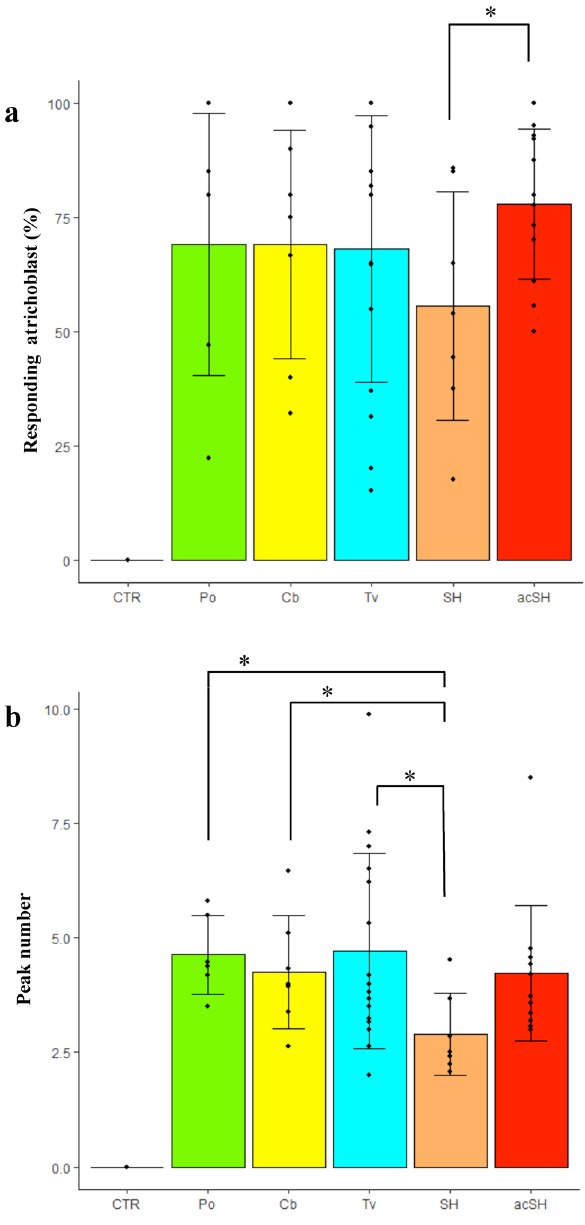
Figure 3. Calcium spiking response to 1 mg/L CO treatment in M. truncatula atrichoblasts. All CO solutions activated nuclear calcium spiking, in a comparable number of cells (expressed as percentage in a ). Nevertheless, the average number of peaks recorded over 30 min ( b ) indicated a significantly stronger response to fungal compared to shrimp COs. Remarkably, this difference was canceled when shrimp COs acetylation degree was increased by peracetylation. CTR = water-treated control; Po = P. ostreatus COs; Cb = C. berthollethiae COs; Tv = T. viride COs; SH = shrimp-derived COs; acSH = peracetylated shrimp-derived COs. A minimum of six biological replicates were evaluated for each treatment. Significant differences are marked by an asterisk (Student’s t test: P < 0.05); the difference between CTR and each CO treatment was highly significant in both analyses (Student’s t test: P <